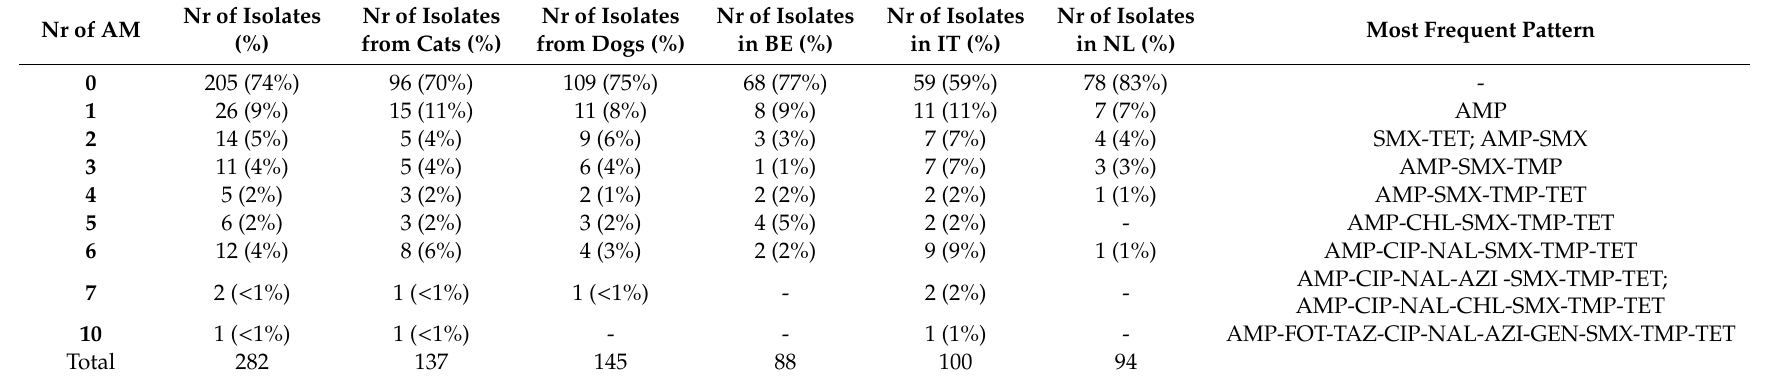
Table 2. Phenotypes of resistance among Escherichia coli isolated from feces of dogs and cats in three European